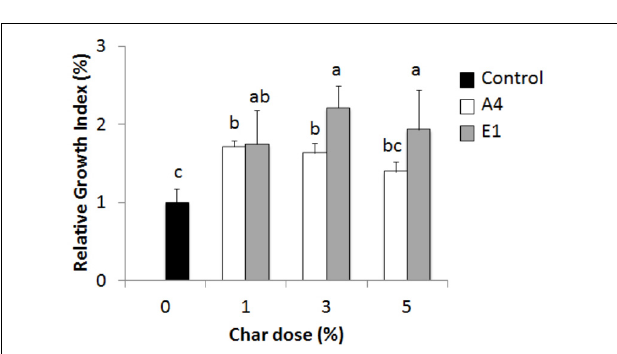
FIGURE 10 | Relative growth index (RGI) of Hordeum vulgare seedlings germinated for 72 h in the presence of chars from pyrolysis of different feedstocks at increasing concentrations (1 to 5%). White bars, char A4; gray bars, char E1. Means of 30 seeds relative to growth of the control in pure soil (black bar) are reported with standard errors. Letters indicate significant differences assessed with one-way ANOVA at p <